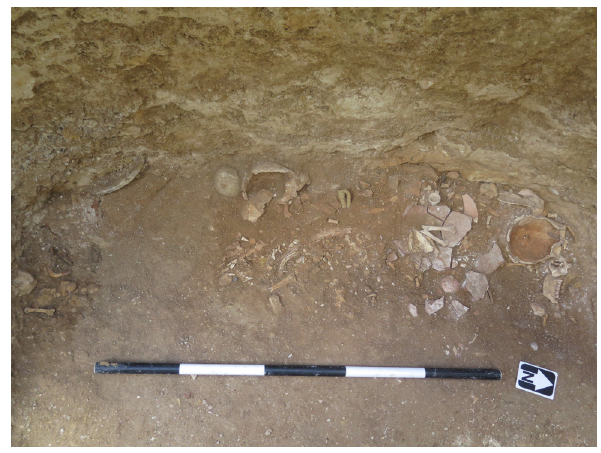
Figure 7: Intermediate phase II: Infant burial 2 on large pot SU36 and partial uncovering of Skeleton 7 with special fi